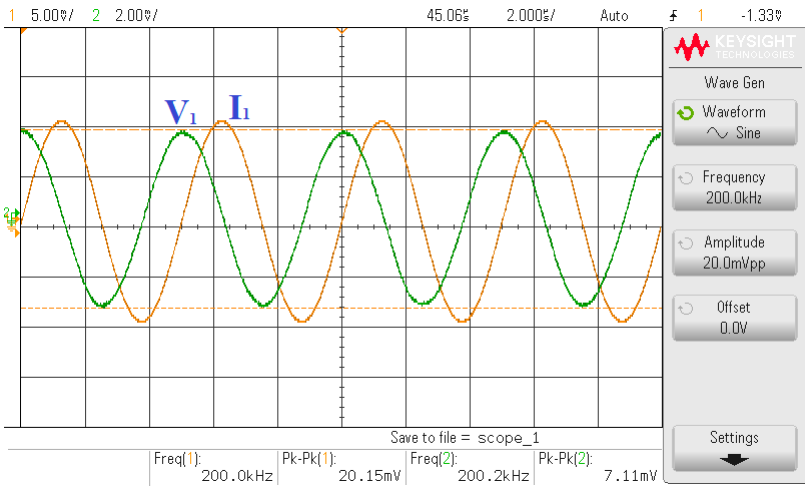
Figure 34. The current and voltage measured at port v 1 of the floating lossless inductance simulator.